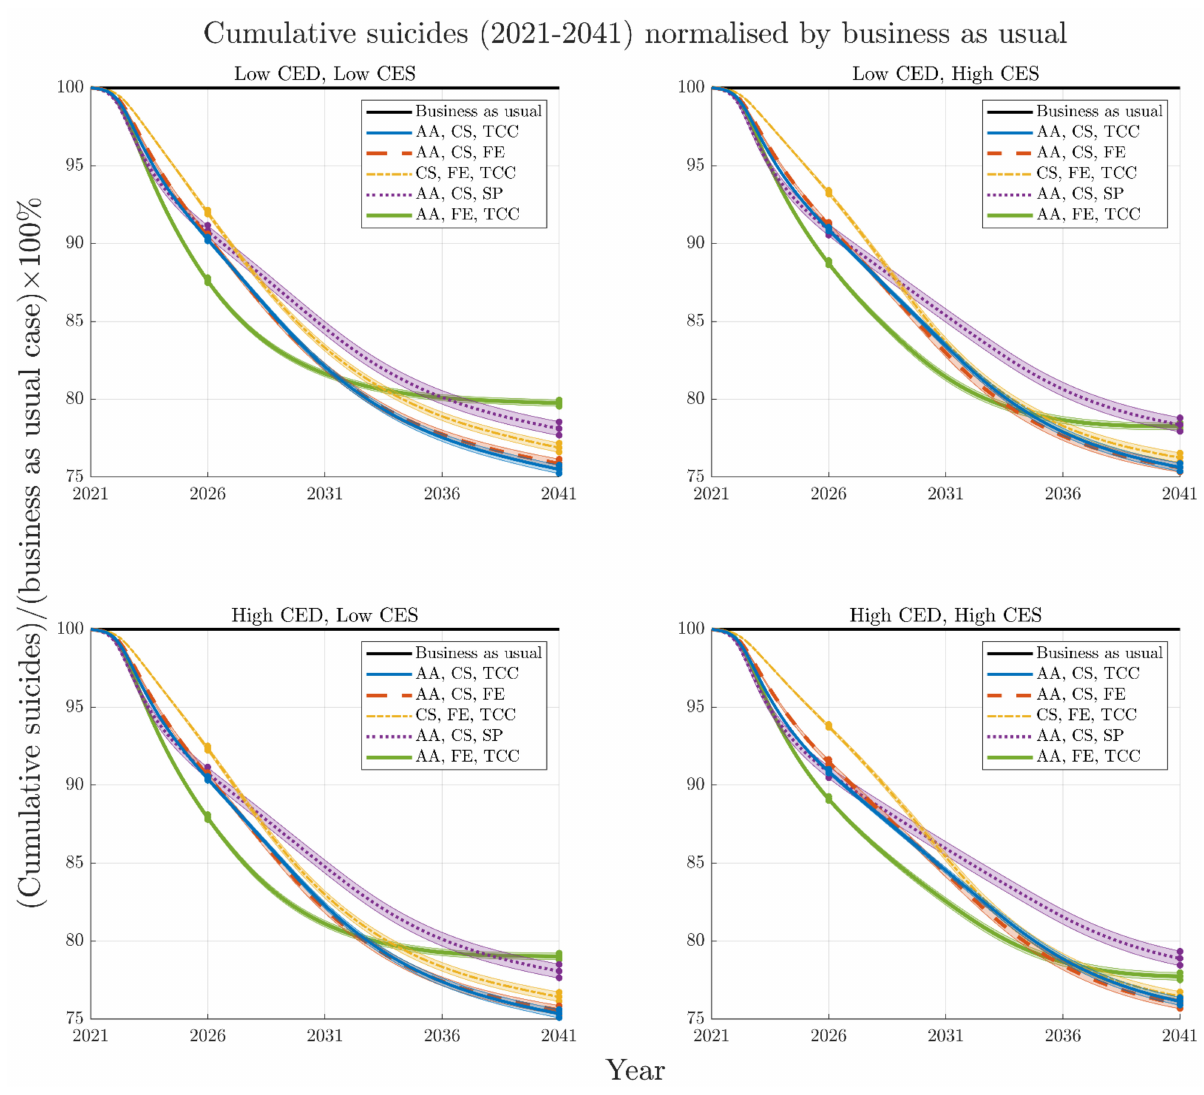
Figure 6. Mean and 95% intervals of cumulative suicides for each top performing combination of interventions (normalised by respective business as usual cases) for the four COVID-19 mental health scenarios (A–D) from 2021–2041. Time slices illustrated in Figures 3 and 5 are noted at 2026 and 2041. Note that while different combinations of interventions change rankings over time, the rankings (including 95% intervals) remain similar regardless of the severity or duration of the COVID-19 mental health